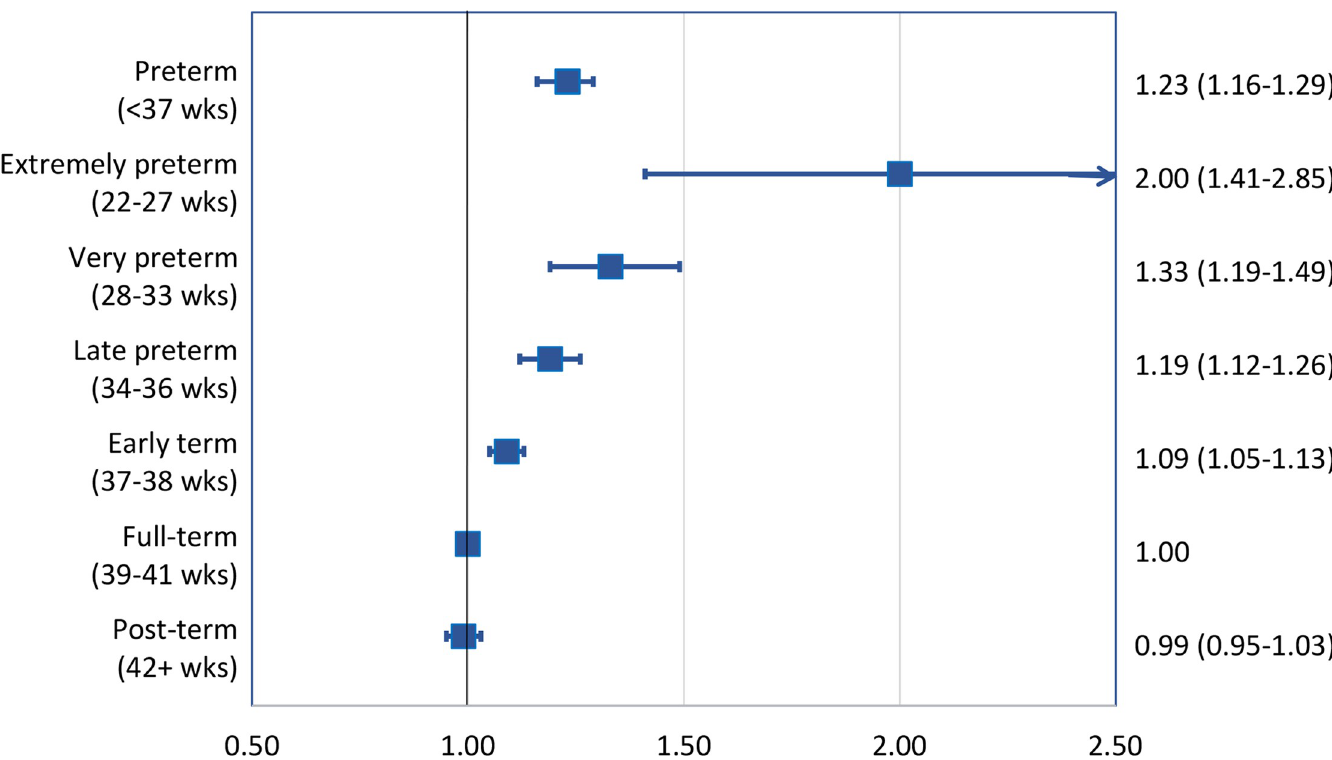
Fig 1. Adjusted HRs and 95% CIs for risk of lipid disorders by gestational age at birth compared to full-term birth, Sweden, 1973–2016. HR, hazard